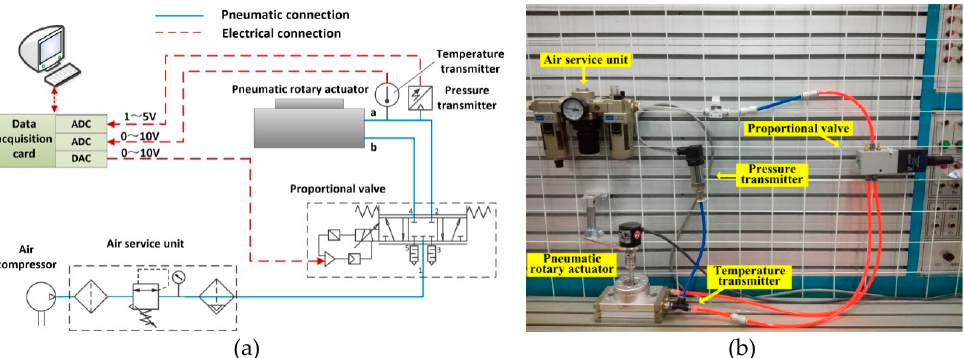
Figure 12. Pneumatic circuit for testing the heat transfer coefficient h : ( a ) Schematic diagram; (b) Test